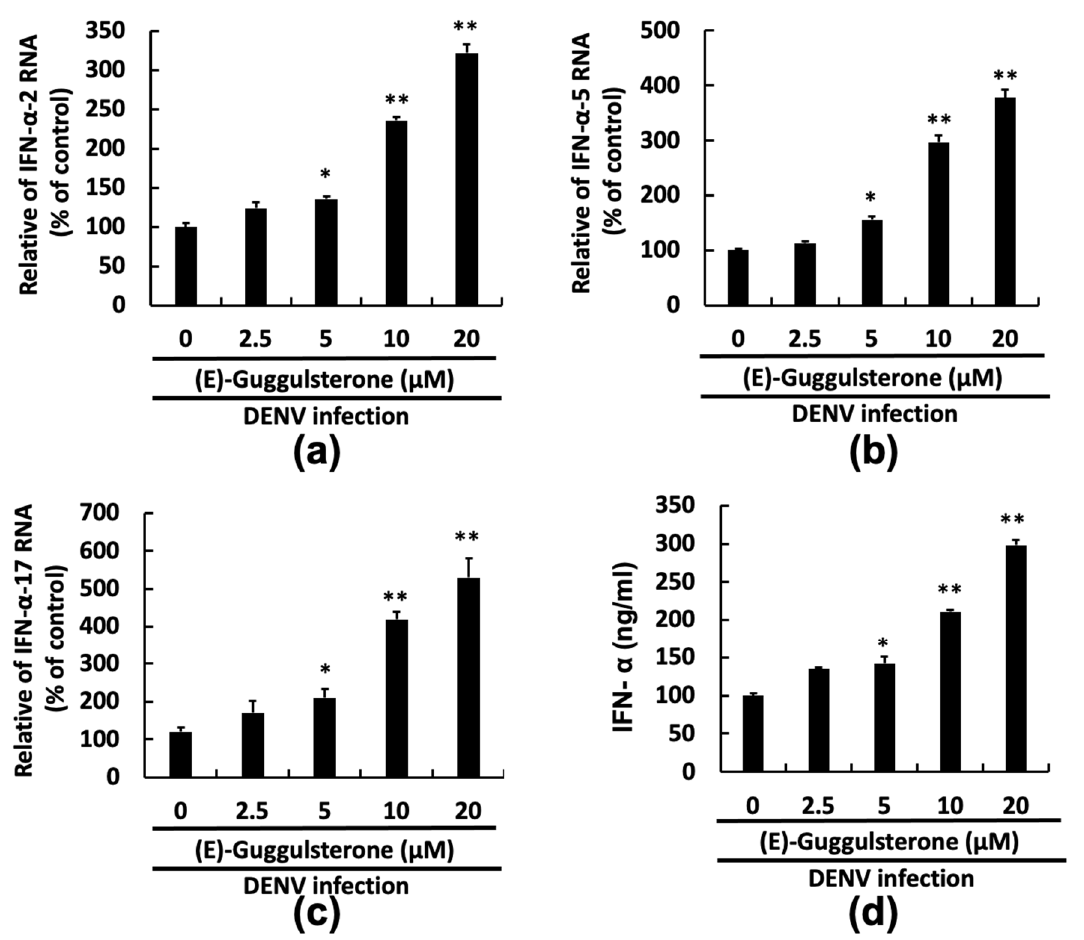
Figure 5. (E)-Guggulsterone induces antiviral IFN responses in DENV-infected Huh-7 cells. (E)-Guggulsterone increased the mRNA levels of ( a ) IFN- α -2, ( b ) IFN- α -5, and ( c ) IFN- α -17 in DENV-infected Huh-7 cells. Huh-7 cells were infected with DENV and then treated with the indicated concentrations of (E)-guggulsterone (0–20 µ M) treatment for 3 days. The mRNA level of IFN- α was analyzed using RT-qPCR. ( d ) (E)-guggulsterone upregulated DENV-suppressed IFN- α protein expression in DENV infected Huh-7 cells. ELISA was used to determine the IFN- α protein levels in the culture media. The relative percent induction was compared to the DENV-infected cells treated with 0.1% DMSO, defined as 100%. Here “0” was regarded as the treatment with 0.1% DMSO. Error bars denote the mean ± SD of three independent experiments ( n = 3); * p < 0.05, ** p < 0.01.